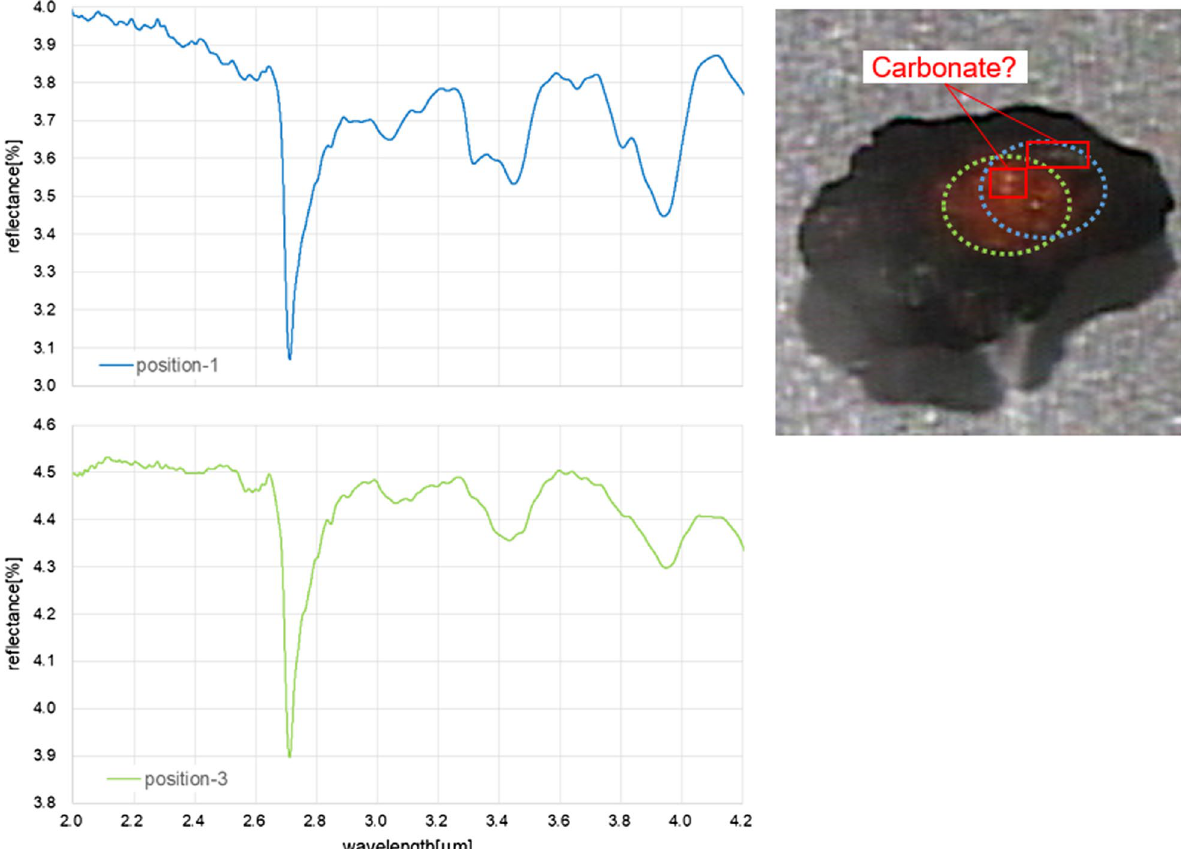
Fig. 9 Deformation of carbonate spectral feature by shifting the measurement area observed in A0059. Dashed circles on the optical images show measurement areas corresponding to the spectra of position 1 (blue) and position 3 (green). Carbonate inclusion is not apparently visible but might be the small white areas on the